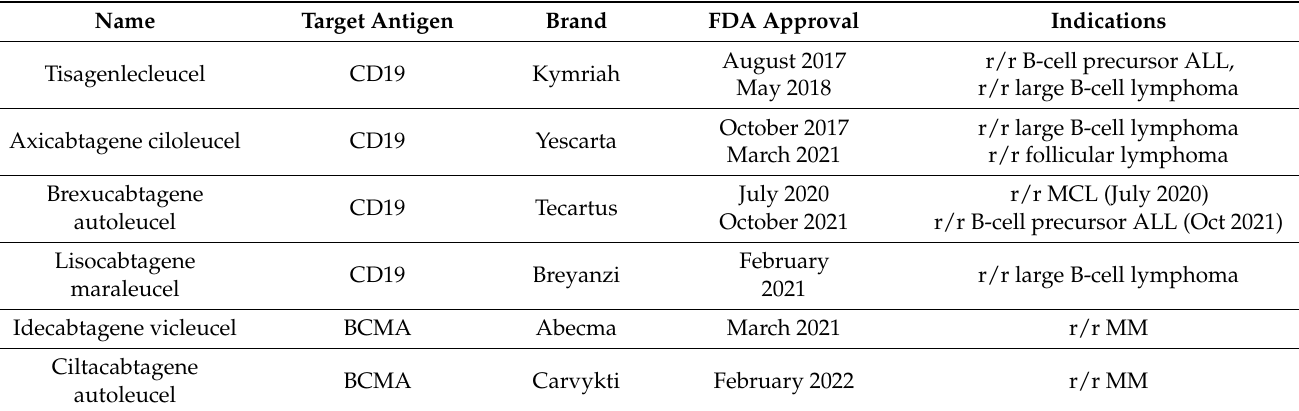
Table 1. FDA-approved CAR T cell